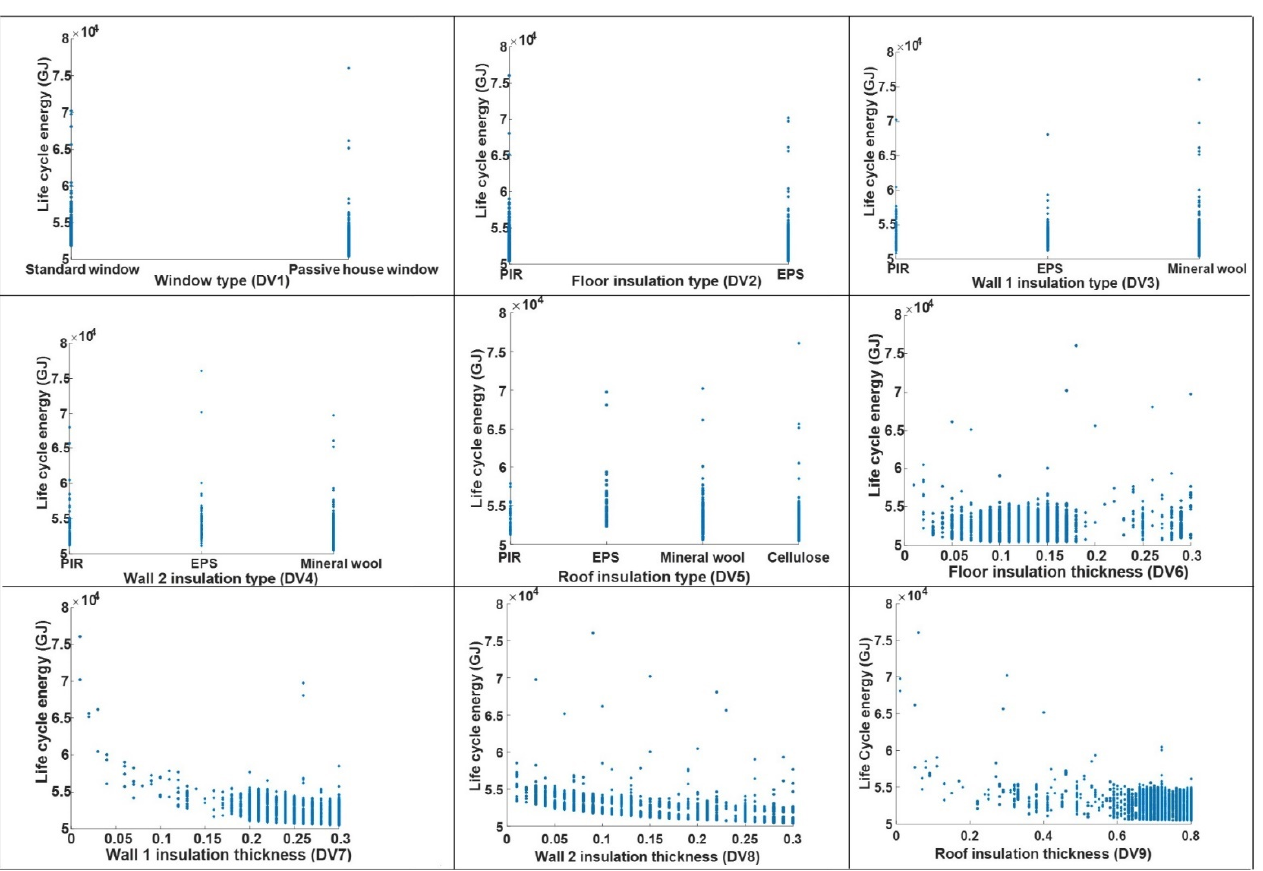
Figure 9. Distribution of all identified solutions in the solution space for the nine design variables studied in the case study. studied in the case